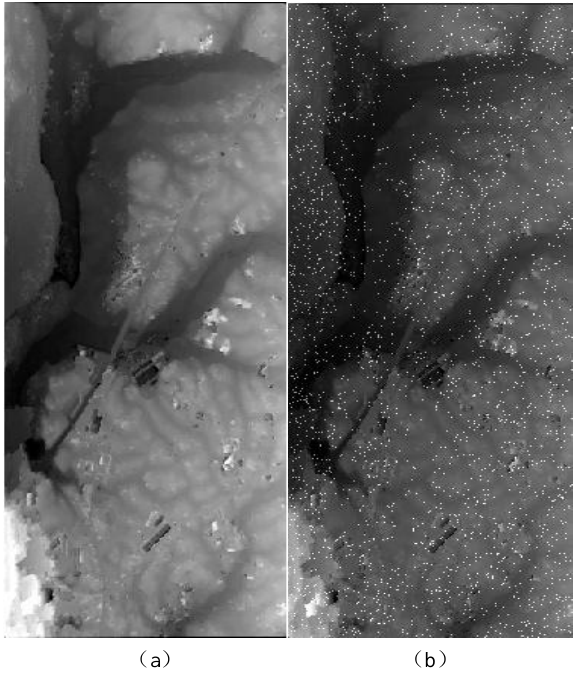
Figure 6. （ a ） Elevation map without adaptive threshold segmentation ；（ b ） Elevation map with adaptive threshold